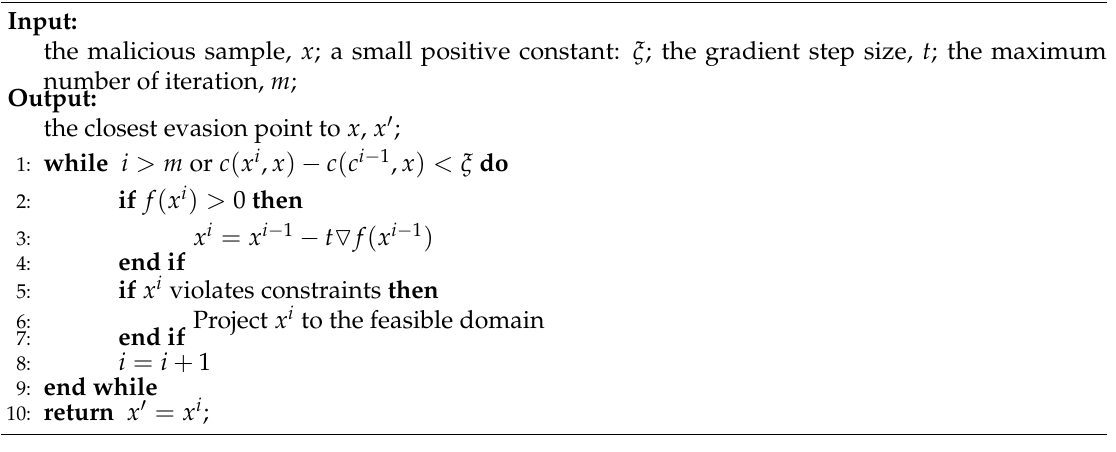
Algorithm 1 Gradient-based Evasion